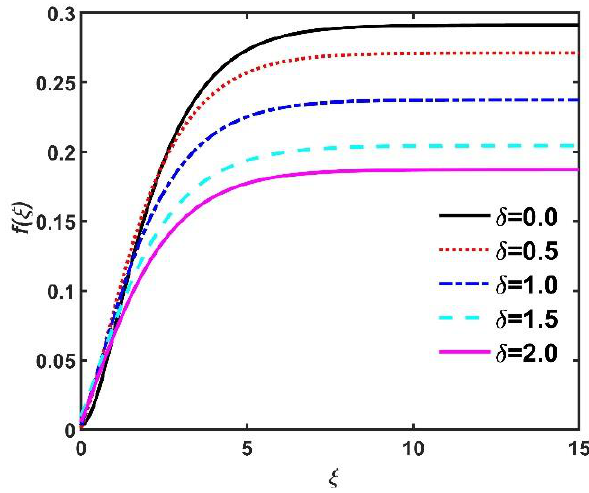
Figure 18. Impact of 𝛿 on 𝑓(𝜉) .